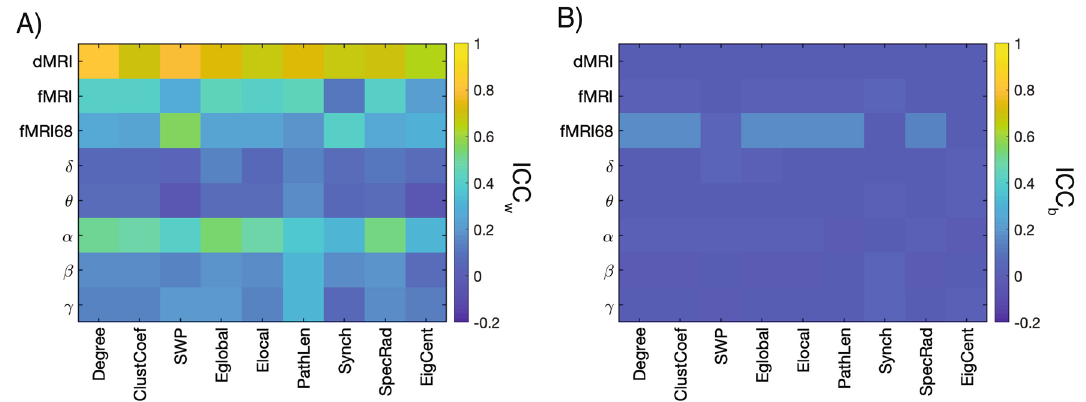
Figure 5. Graph Measures for dMRI and Resting-State fMRI and EEG for ( A ) ICC w and ( B ) ICC b values. For fMRI data, the analysis was conducted using both the Schaefer 200 (fMRI) and Desikan-Killiany (fMRI68)